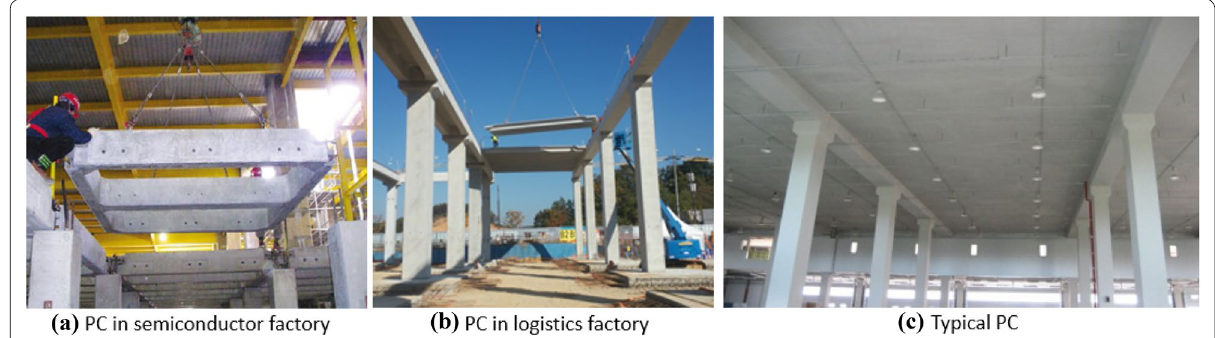
Fig. 1 Construction of typical PC beam–concrete column connection.